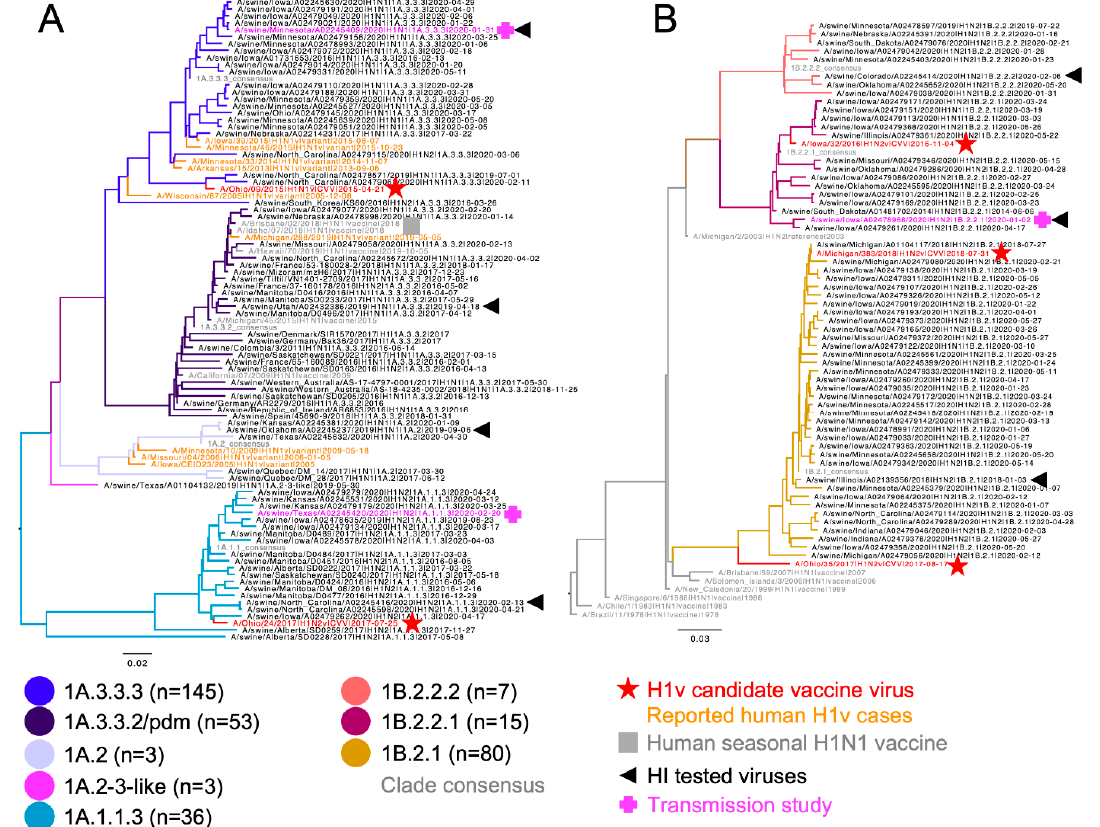
Figure 1. Phylogenetic relationships of North American swine H1 IAV. A representative random sample of ( A ) 1A classical swine lineage and ( B ) 1B human-like lineage swine HA genes from January 2020 through June 2020. Reference human HA genes, CVV, and variant cases are indicated by branch color or shapes. Swine IAV strains tested in hemagglutination inhibition assays are marked by a black triangle and those used in transmission studies by a pink plus (+). The numbers in parentheses in the color key indicate number of each genetic clade detected during the sampling period.